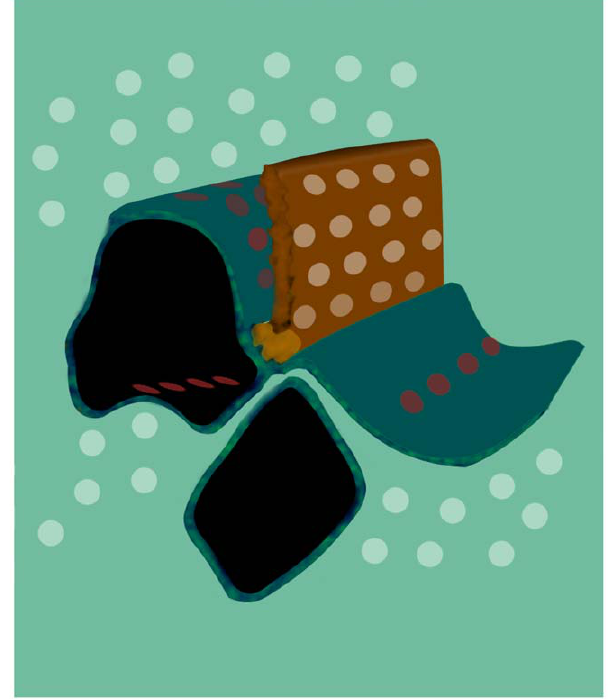
Figure 7. Model of rod photoreceptor ribbon synapse. To impart three-dimensionality, the synaptic ribbon, the tethered vesicular pool and the endings of the horizontal cells were extended along the z-axis. Docked vesicles are located at ribbon-associated (green) and at ribbon- free regions (red circles) the synaptic terminal. The distribution of docking and fusion sites along the entire synapse could account for the capacity of ribbon synapses to release glutamate in a rapid and sustained manner during prolong depolarization.